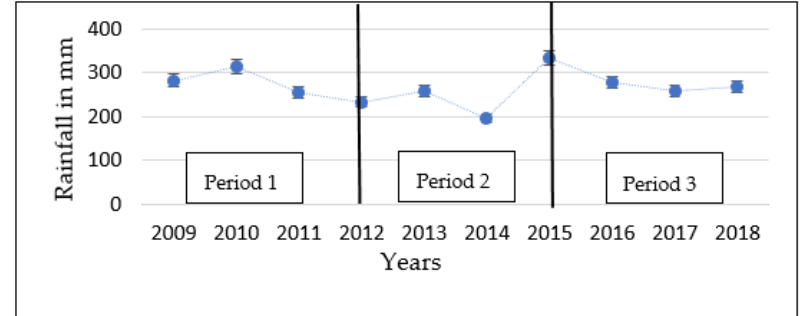
Figure 5. Annual evolution of rainfall: 2009 to 2018. Source CRHS 2021.